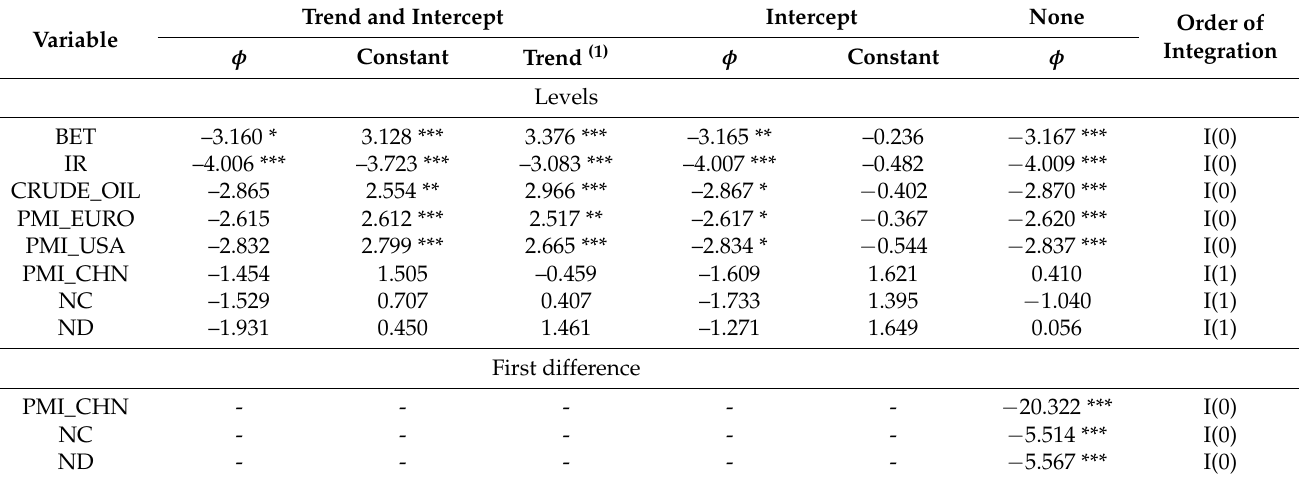
Table 4. Results of the Augmented Dickey–Fuller (ADF) unit root